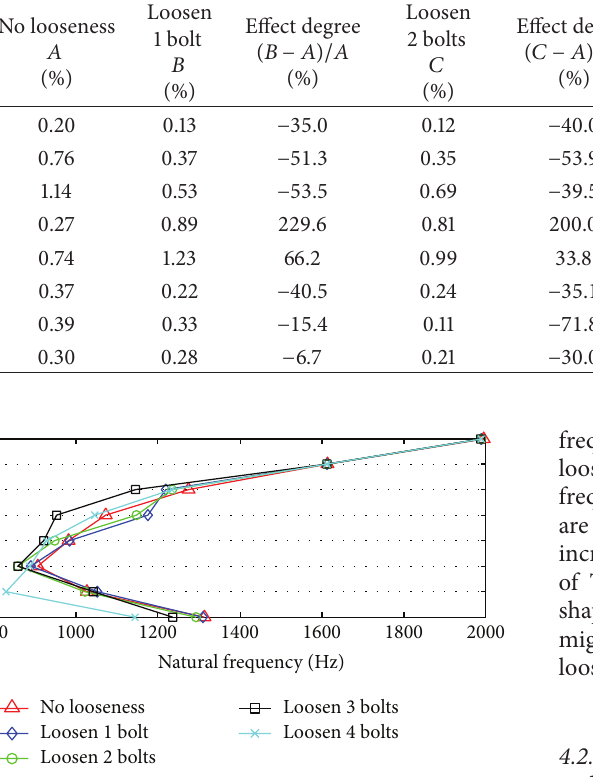
Figure 13: The relation between natural frequency and mode shape under BLB with different looseness